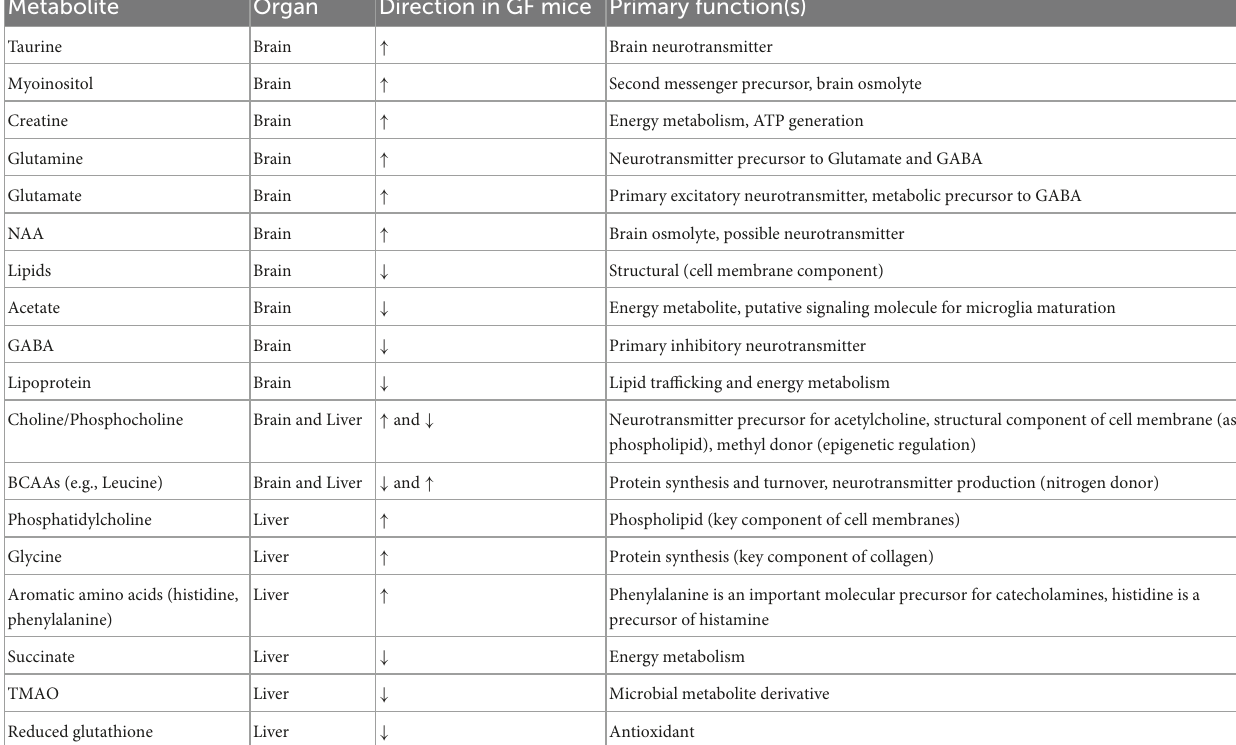
TABLE 2 Summary of metabolic changes in the brain and liver of germ free